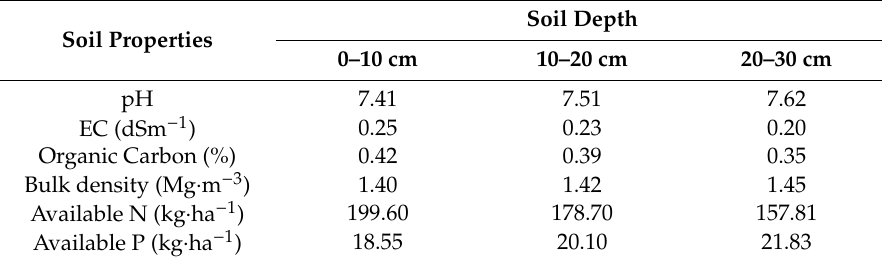
Table 1. Physico-chemical properties of the soil of experiment field.